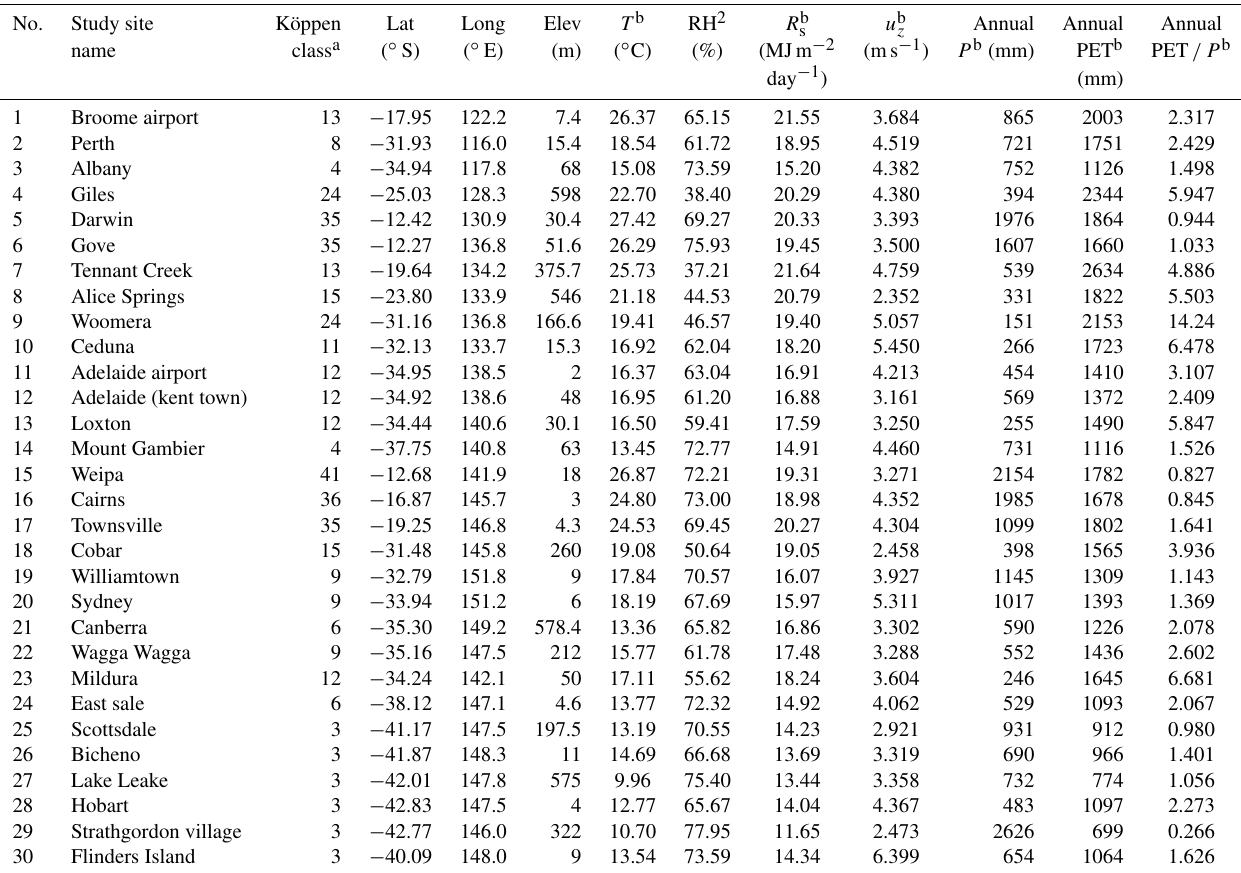
Table 1. Names, locations and average climate conditions of the 30 weather stations over the study period (1995–2004).